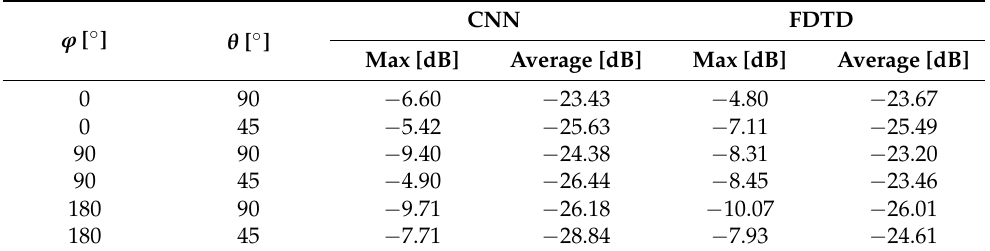
Table 4. Comparison between maximum and average values of power density obtained for the head region.